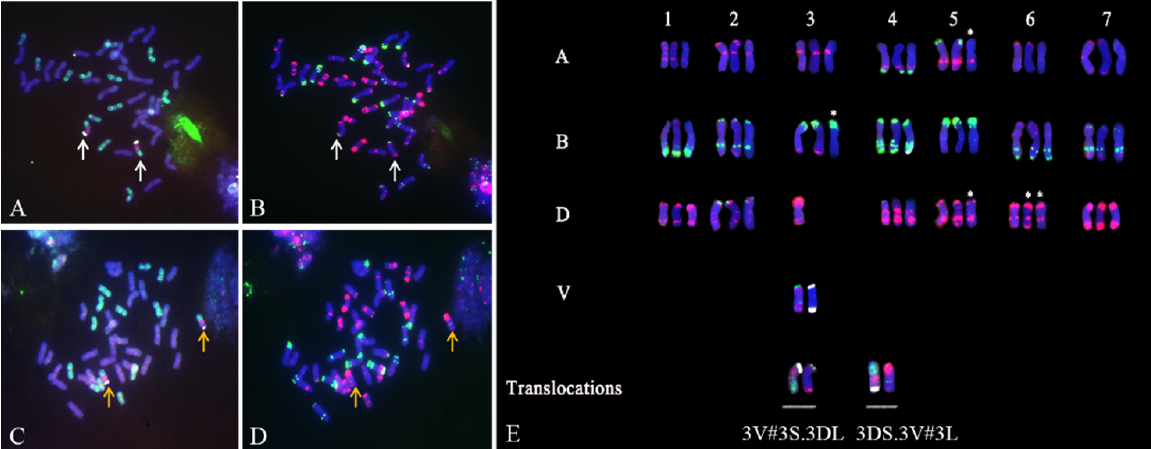
Figure 1. FISH patterns of 22-12 and 24-20. ( A , C ), Chromosomes of 22-12 ( A ) and 24-20 ( C ) stained with DAPI (blue), Oligo-Ku (red), Oligo-PHV62-1(white) and Oligo-D (green). ( B , D ), Chromosomes of 22-12 ( B ) and 24-20 ( D ) stained with DAPI (blue), Oligo-pTa535 (red) and Oligo-pSc119.2 (green). ( E ), FISH karyotype of individual chromosomes in CS (left), 22-12 (middle) and 24-20 (right); The A, B, D and V in ( E ) indicated A subgenome, B subgenome, D subgenome and 3V#3 chromosome, respectively; the wheat and 3V#3 chromosomes were stained with DAPI (blue), Oligo-pTa535 (red), Oligo-pSc119.2 (green) and Oligo-pHv62-1(white); the translocations (left) were stained with DAPI (blue), Oligo-Ku (red), Oligo-pHv62-1(white) and Oligo-D (green), and the translocations (right) were stained with DAPI (blue), Oligo-pTa535 (red), Oligo-pSc119.2 (green). The white arrows show 3V#3S.3DL, and the yellow arrows indicate 3DS.3V#3L. The asterisks indicate the chromosomes showing different signal patterns with respect to